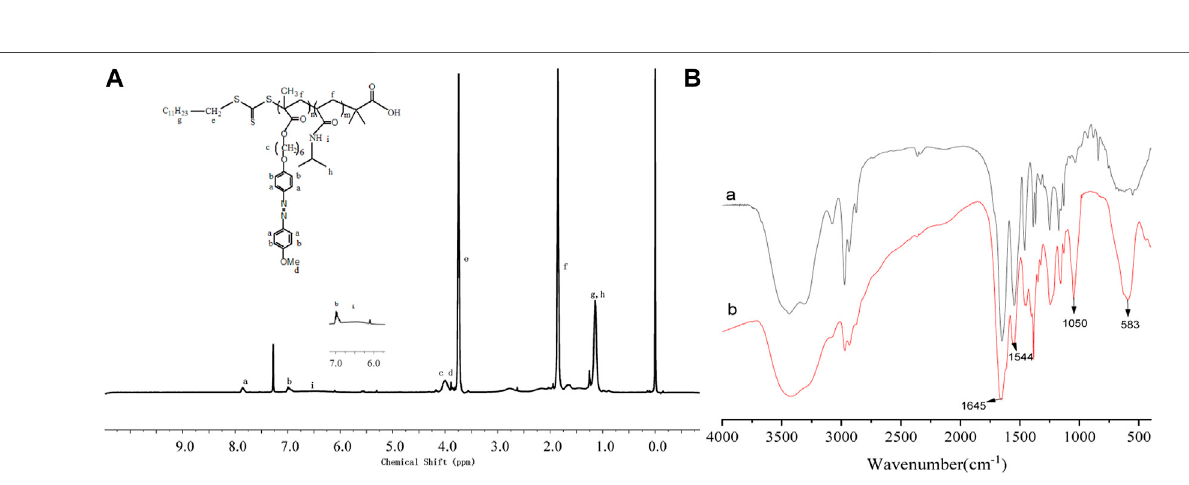
Frontiers in Bioengineering and Biotechnology |